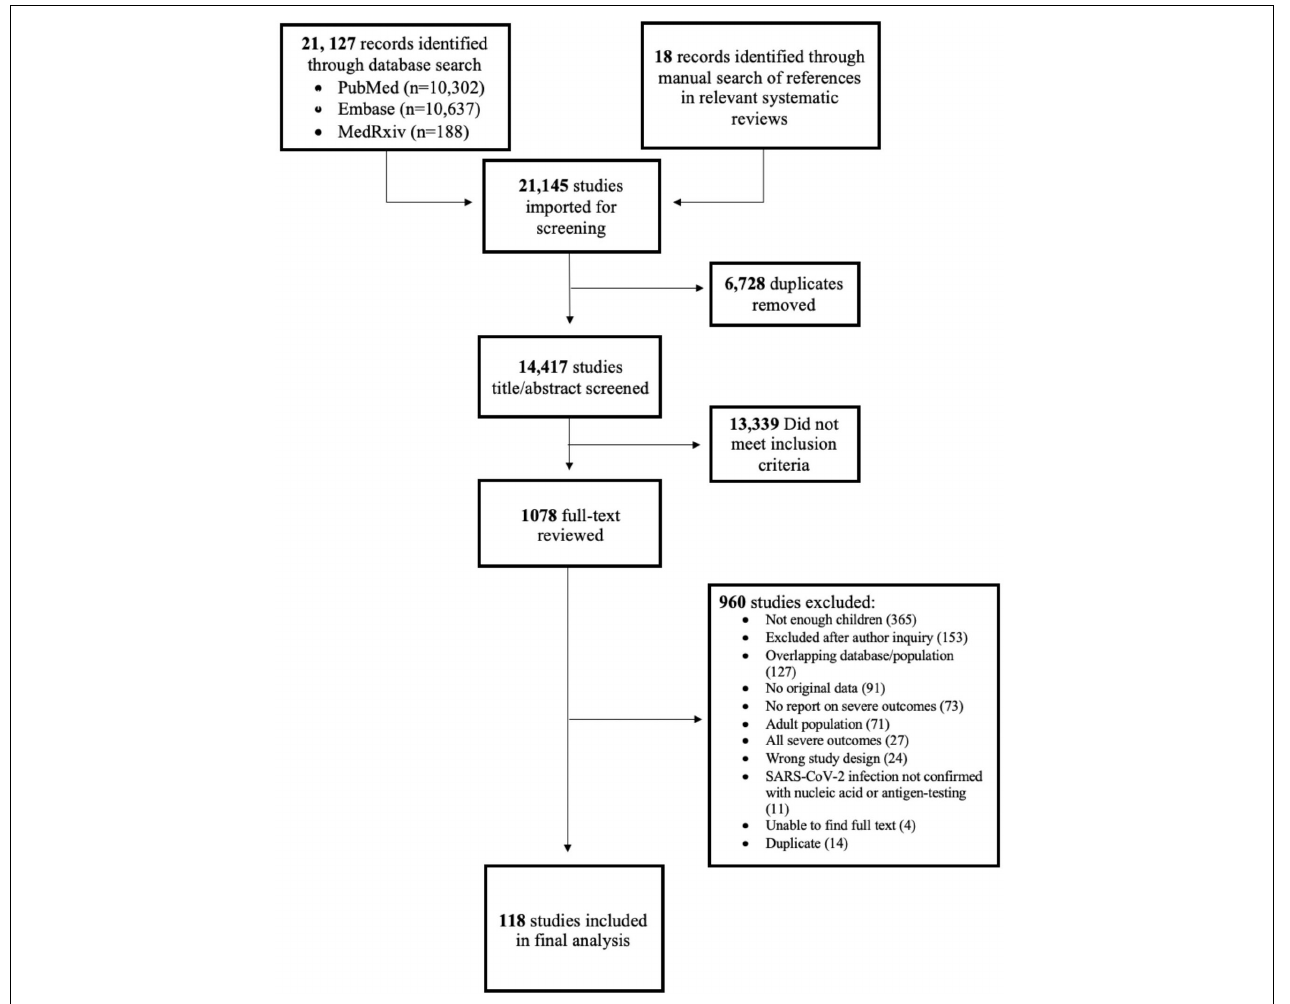
FIGURE 1 | PRISMA